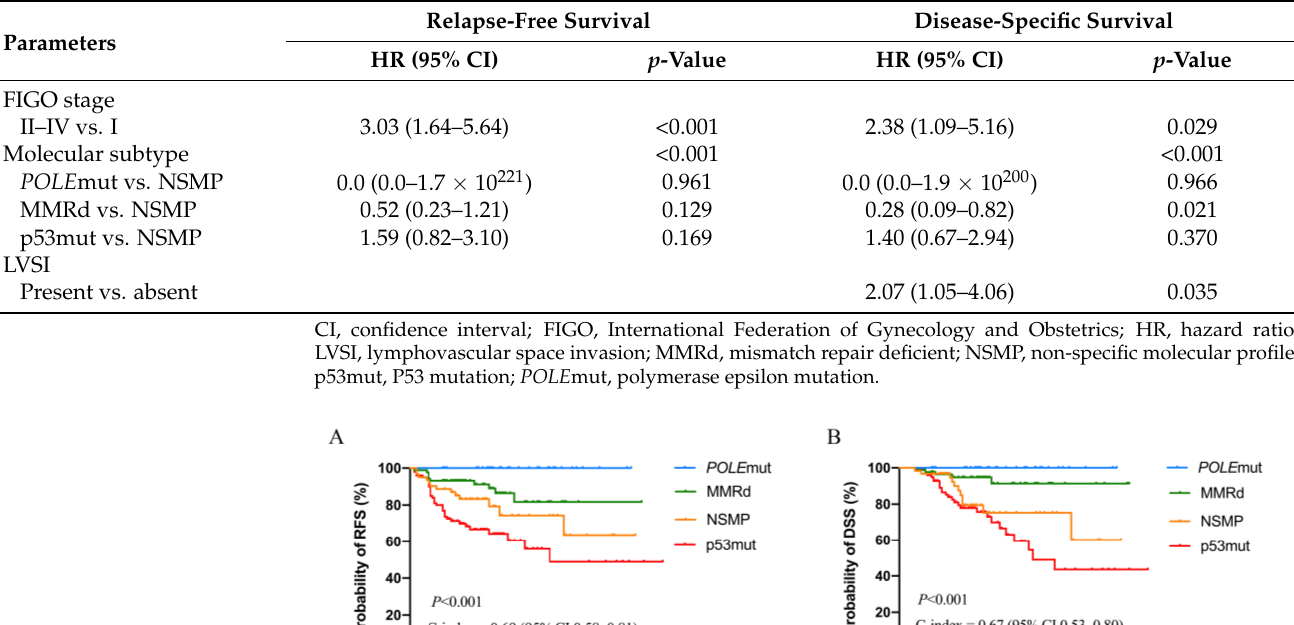
Table 3. Multivariate analysis of factors potentially predictive of survival in patients with high-grade endometrial cancer.